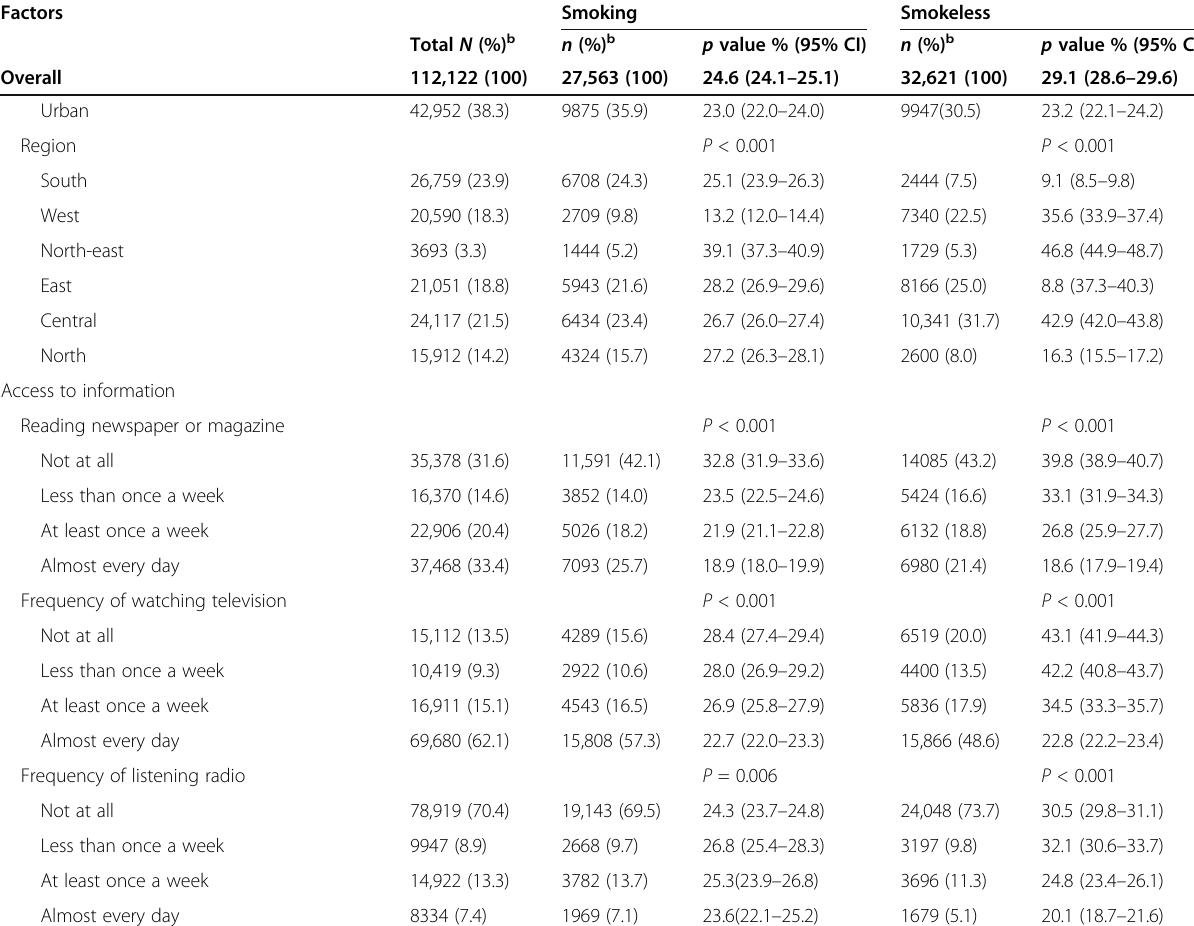
Table 1 Characteristics of the study population and prevalence of smoke and smokeless tobacco use among Indian men by socio- demographic characteristics, India 2015 – 2016 a